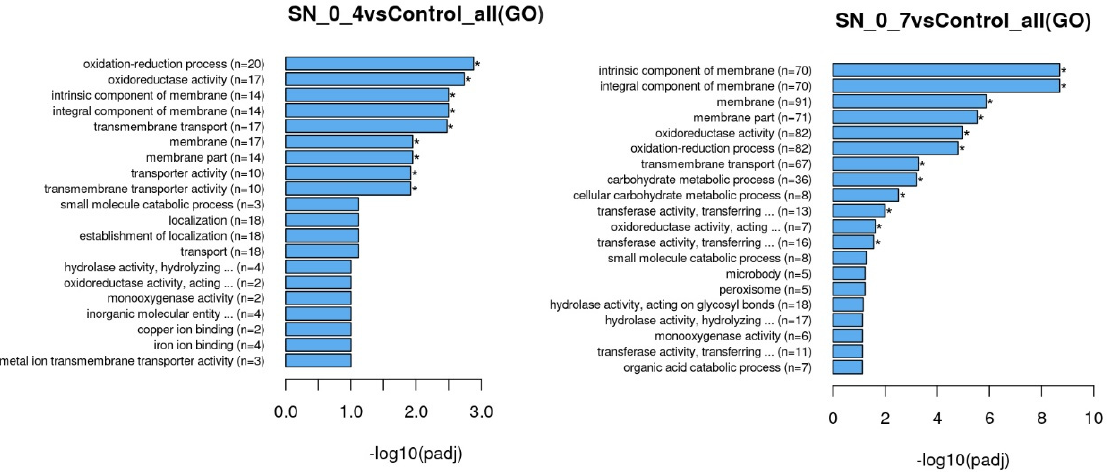
Figure 6. Gene Ontology (GO) Enrichment analysis of differentially expressed genes in SN_0_4 and SN_0_7 samples. SN_0_4: cells incubated in supernatant derived from treatment with 0.4% peroxide; SN_0_7 cells incubated in supernatant derived from treatment with 0.7% peroxide; Control: cells incubated in diluted rich medium. The length of bar charts indicates statistical significance of